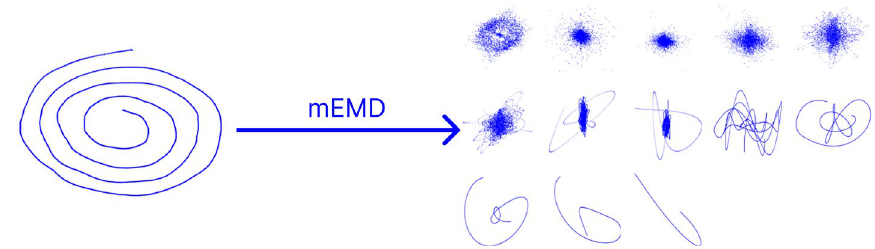
Figure 1. Extraction of IMFs through multivariate empirical mode